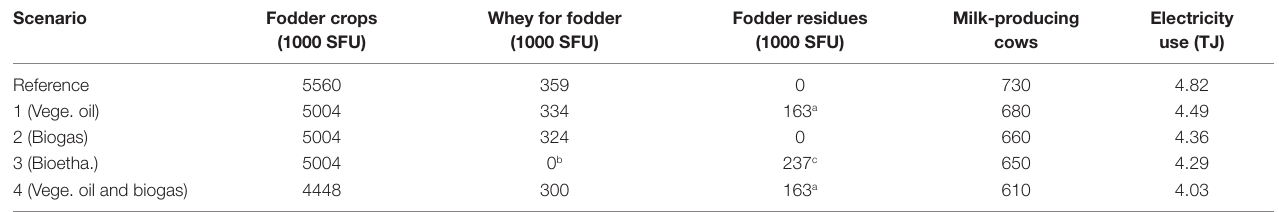
TaBle 3 | inputs to livestock production for the entire system of 1000